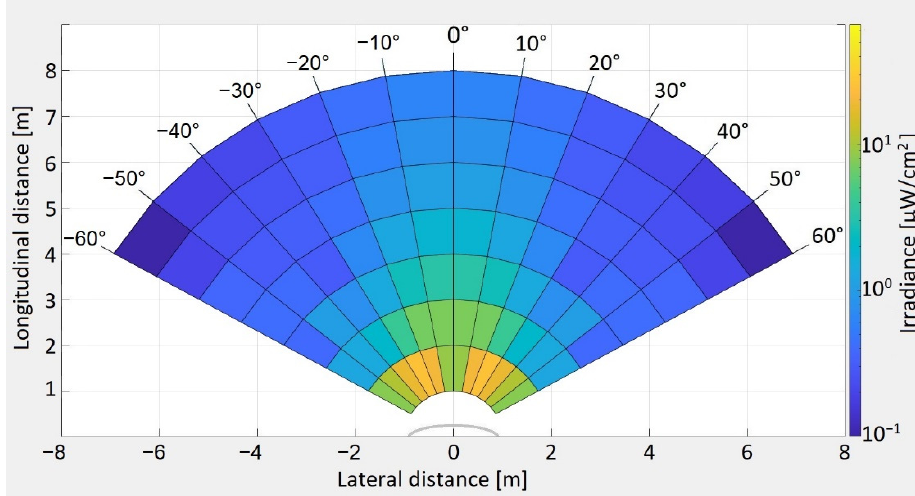
Figure 9. VLC emitter prototype irradiance distribution.